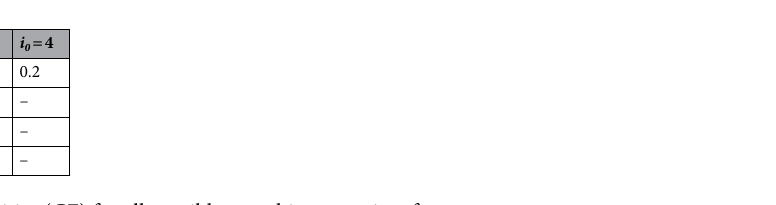
Table 2. Sensor sensitivities (GF) for all possible stretching areas in a four-zone sensor.